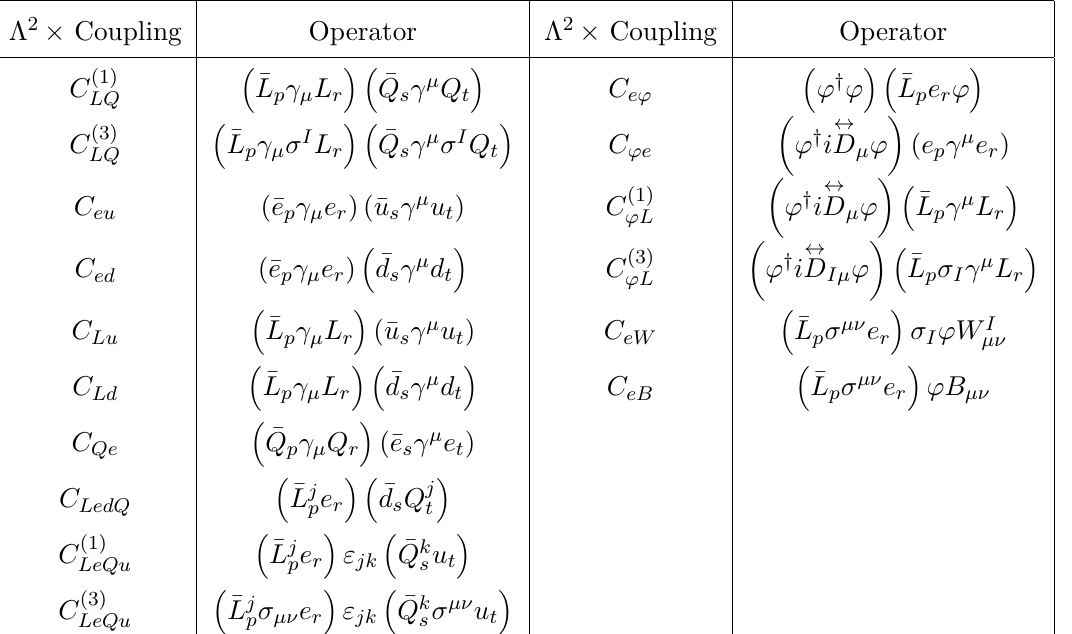
Table 1 . D = 6 operators appearing in the Lagrangian (1.1) and contributing to the CLFV processes that we study in this work. The four-fermion operators appear on the left-hand side, while those involving the Higgs doublet ϕ and the gauge bosons are on the right. The notation (up to small apparent changes), is the one from ref. [31]. For the family indices we use p , r , s and t , while j and k are isospin indices. For I = 1 , 2 , 3 , σ I are the Pauli matrices, with ε = iσ 2 , and σ µν ≡ i [ γ µ , γ ν ] . Λ is then the scale where the new dynamics arises. The operators share the same 2 notation with the associated couplings, substituting simply C → O , i.e. O (1)